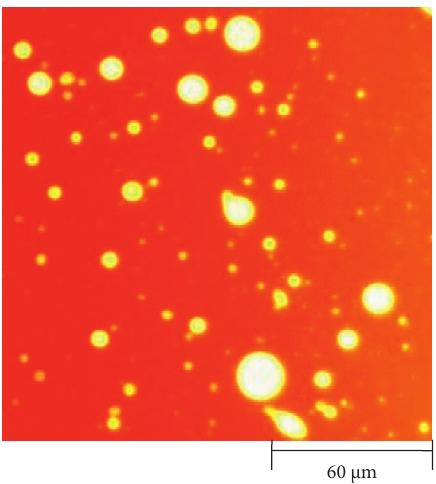
Figure 7: Fluorescence micrographs of undeveloped SBS modified asphalt with 20% content of